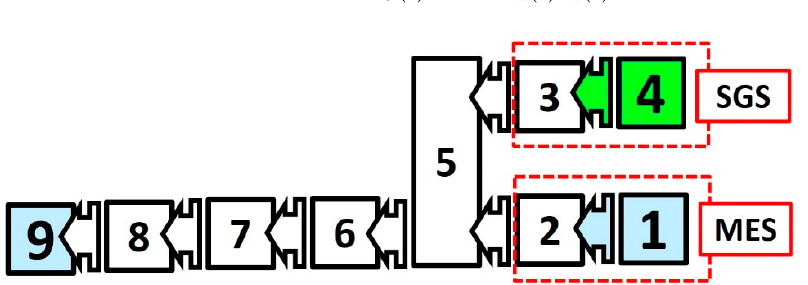
Figure 4. Scheme of main propulsion of the ship with shaft generator and PTO/PTI system: 1—two- stroke main motor; 2—hydraulic coupling; 3—shaft generator gear; 4—shaft generator (PTO/PTI); 5—intermediate shaft; 6—thrust bearing of intermediate shaft; 7—bearing of screw shaft; 8—stern tube; 9.—fixed pitch propeller; SGS —shaft generator systems; MES —main engine set (own elaboration).